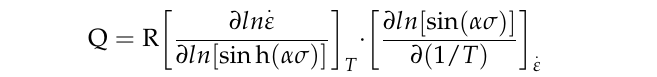
Figure 3. The relation curves between ln σ , σ and ln . ε ; ( b ) the relation between σ and ln ln